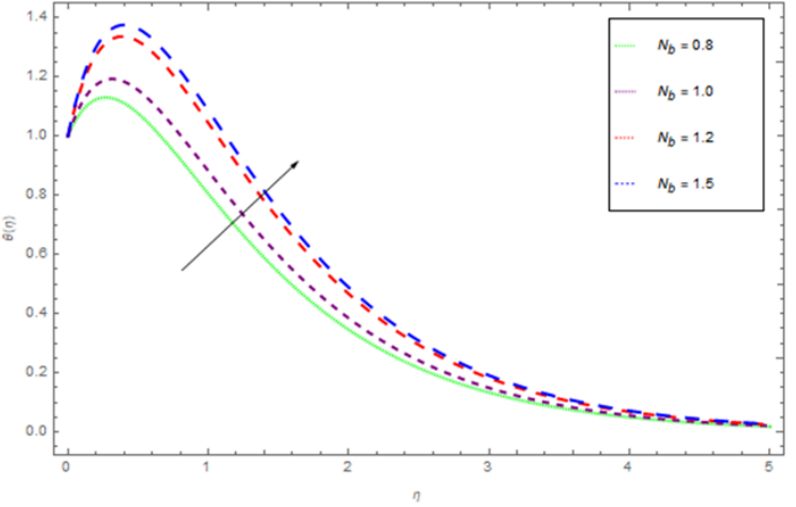
Coatings 2020 , 10 , x; doi: FOR PEER REVIEW Figure 6. The variation of f (cid:48) ( η ) with λ , when M = 0.6, k 1 = 0.5, λ = 0.3, γ = 0.4. Figure 6. The variation of () f   with  , when k    .